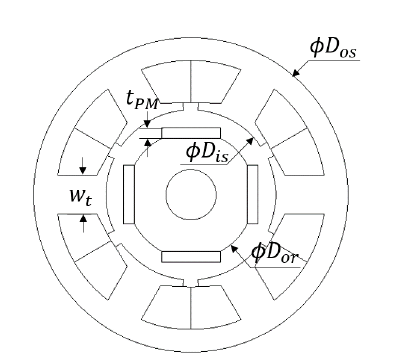
Figure 7. Cross-section of target SPMBSM and relevant geometric variables for